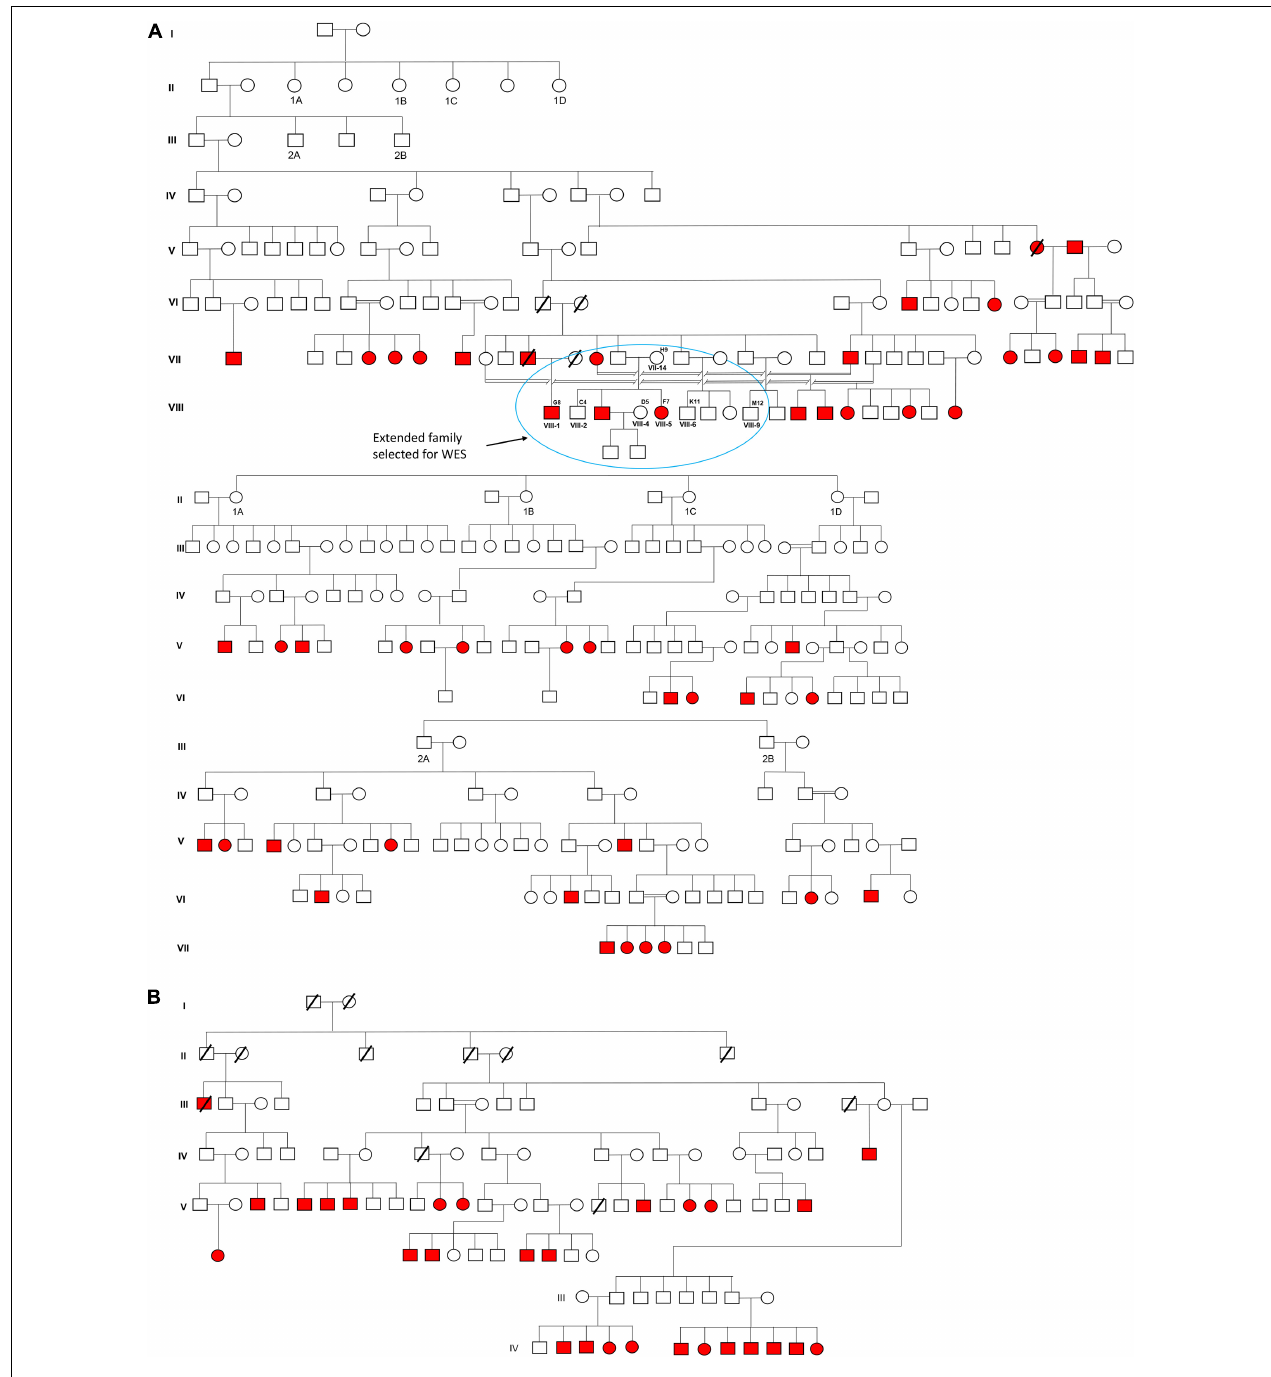
FIGURE 1 | Pedigree and inheritance of deaf-mute syndrome in the families. (A,B) are the two large family trees and (A) have two sub-family trees expatiated from its first and second generations. The extended family from the first family tree (circled blue) was considered for whole-exome sequencing. The squares and circles represent males and females, respectively, where the cases are presented in red color.